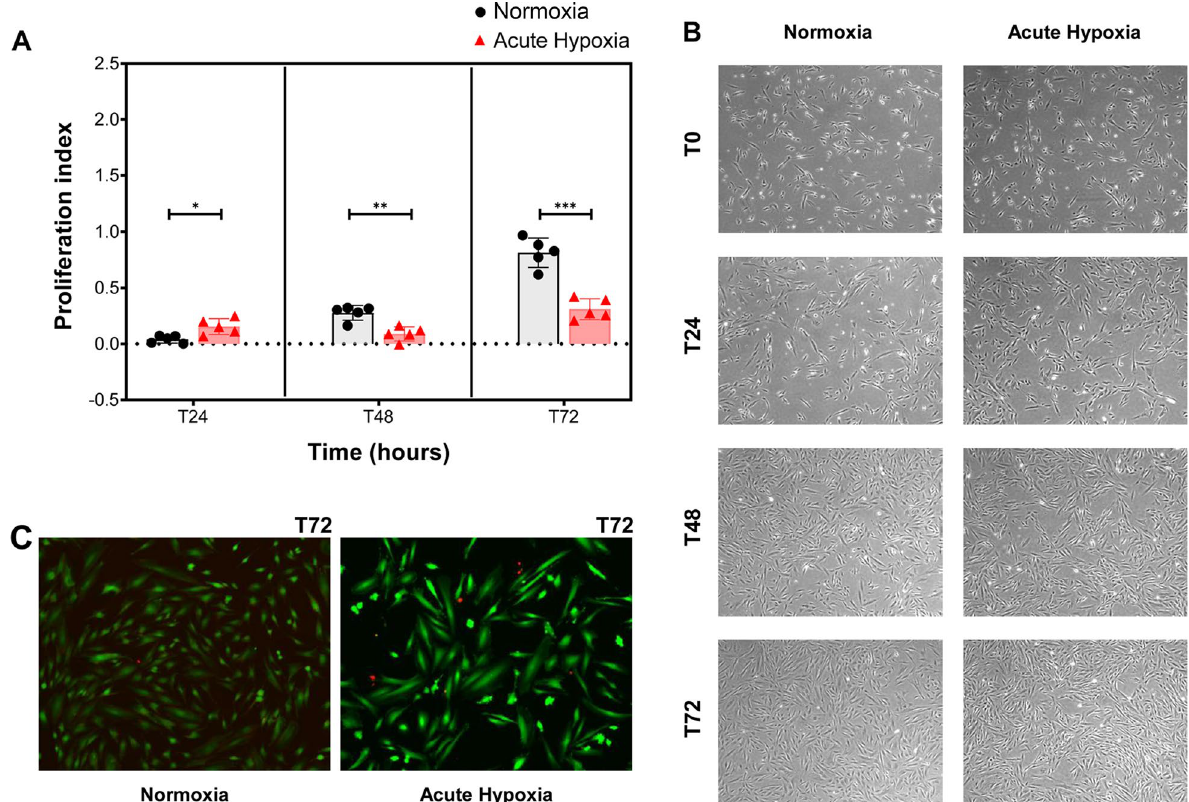
Fig. 2 Effects of acute hypoxia on MenSCs: proliferation and viability. A Proliferation assay in MenSCs under normoxia (black dots, n 5) or in acute = hypoxia (red triangles, n 5) at 24, 48, and 72 h. Values were normalized to the results at time 0 h. A paired t‑test was performed and p < 0.05 was = considered statistically significant. Error bars represent the standard deviations of data. Asterisks indicate statistically significant differences: *p < .05, **p < .005, *** p < .0005. B Optical microscopy images of proliferation in the culture flask under normoxia and acute hypoxia conditions, respectively, at 4x. C Representative images of the LIVE/DEAD viability assay at 10 and 72 h. Red cells are considered dead ×